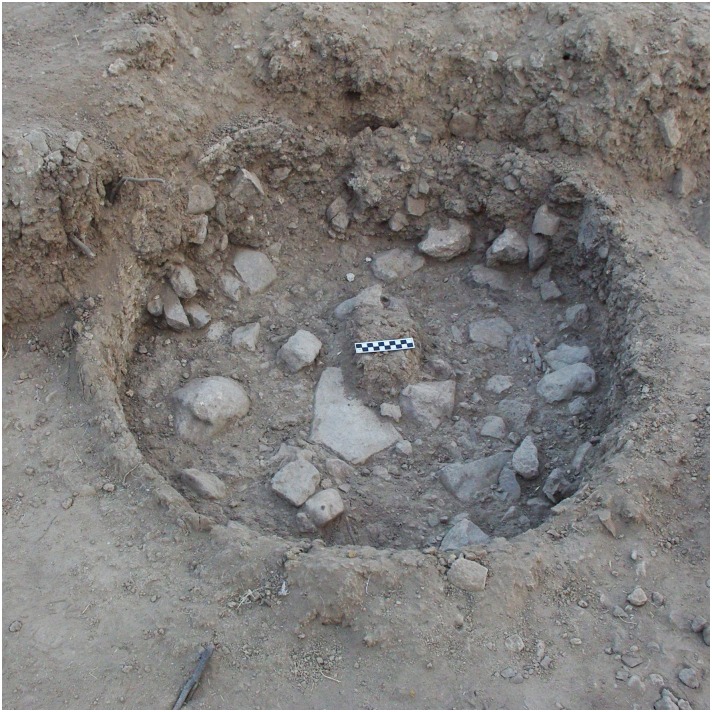
Rounded storage pit.